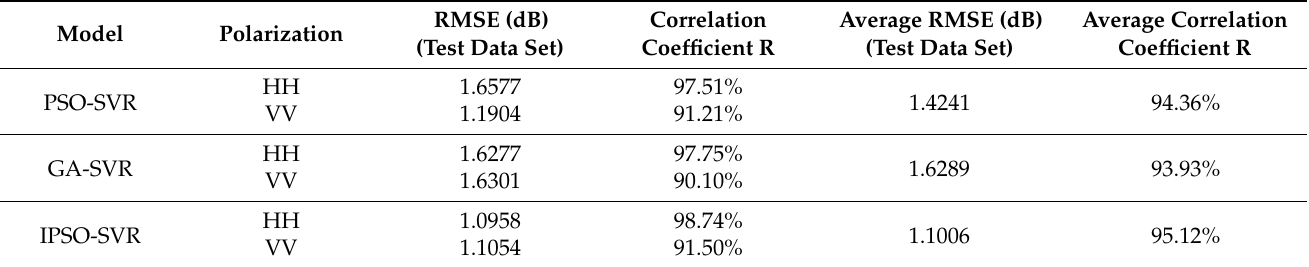
Table 2. Statistical results of calculation error and correlation